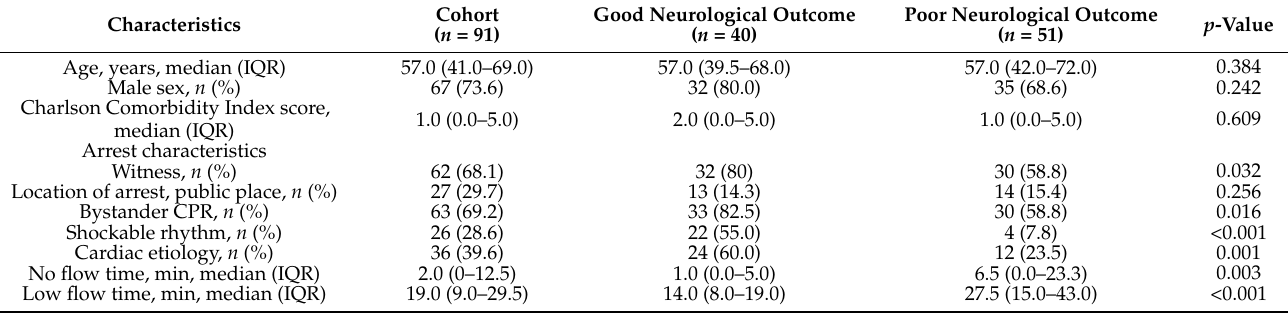
Table 1. Baseline demographic data and arrest